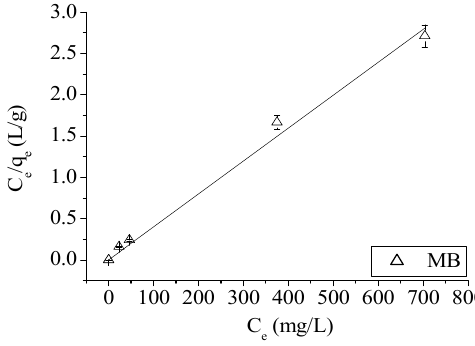
Figure 2. C e / q e vs. C e relation for MB.